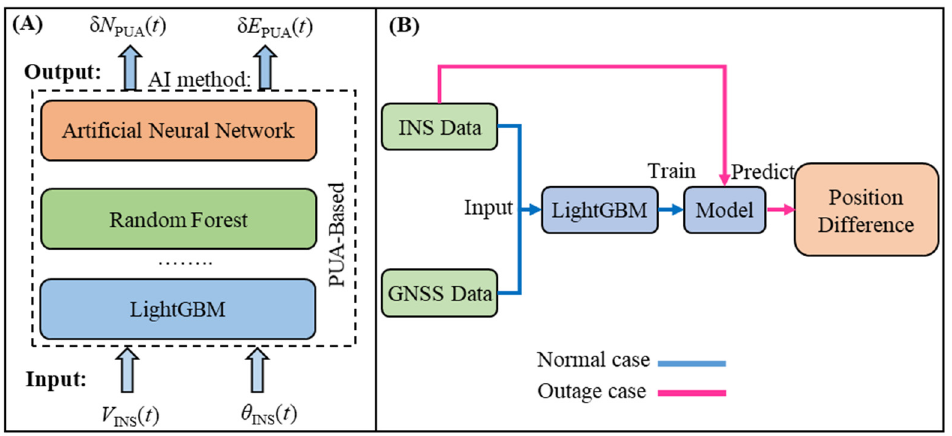
Figure 1. PUA-based LightGBM machine learning model. ( A ) Position update architecture (PUA), t —time; V INS ( t )—Velocity provided by INS at t ; θ INS ( t )—Heading angle provided by INS at t ; δ N PUA ( t )—Latitude difference between epoch t and epoch t − 1; δ E PUA ( t )—Longitude difference between epoch t and epoch t − 1; ( B ) Scheme of the LightGBM machine learning model based on the PUA.